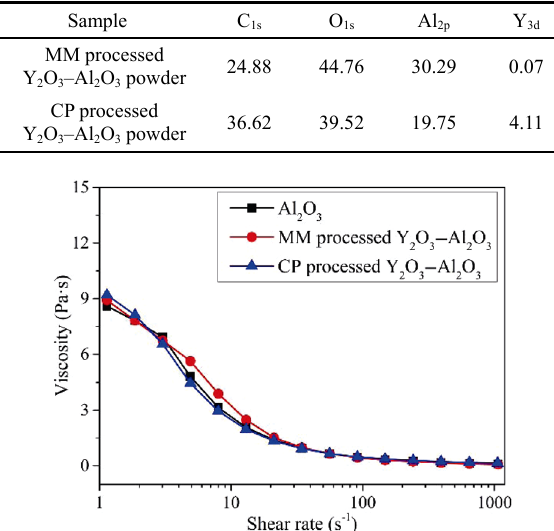
Table 1 Chemical compositions (at%) of the MM and